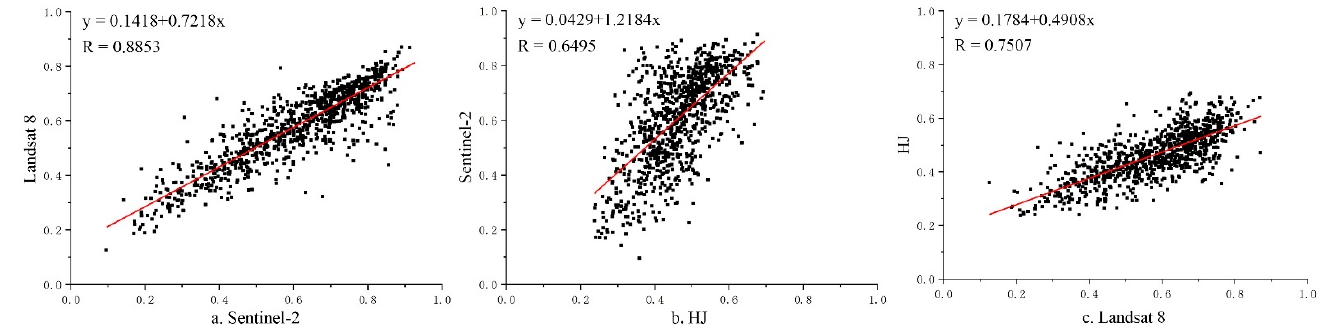
Figure 8. Correlation analysis of NDVI value based on random points (The figures include the conversion equation and correlation coefficient between every pair of sensors for NDVI. ( a ) shows the fitting result of NDVI between Landsat 8 and Sentinel-2; ( b ) shows the fitting result of NDVI between Sentinel-2 and HJ; ( c ) shows the fitting result of NDVI between HJ and Sentinel-2).